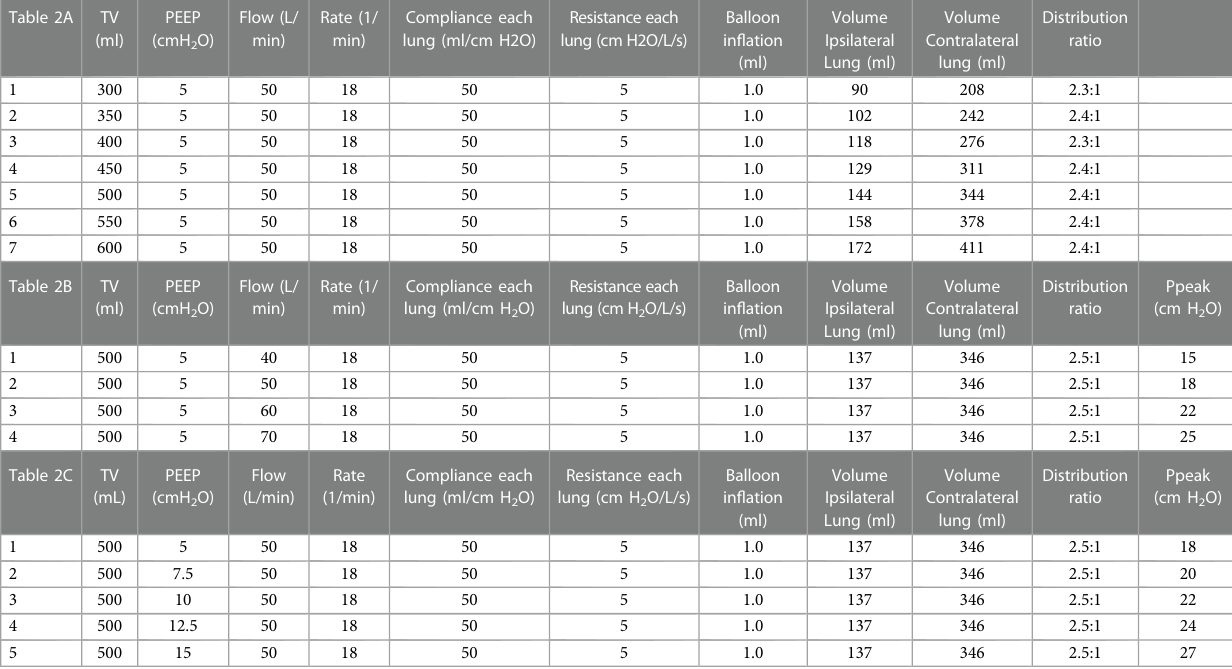
TABLE 2 The effect of tidal volume, fl ow rate and PEEP changes on the SAFR-guided gas distribution. Flow (L/ Table 2A TV PEEP min) (ml) (cmH 2 O)